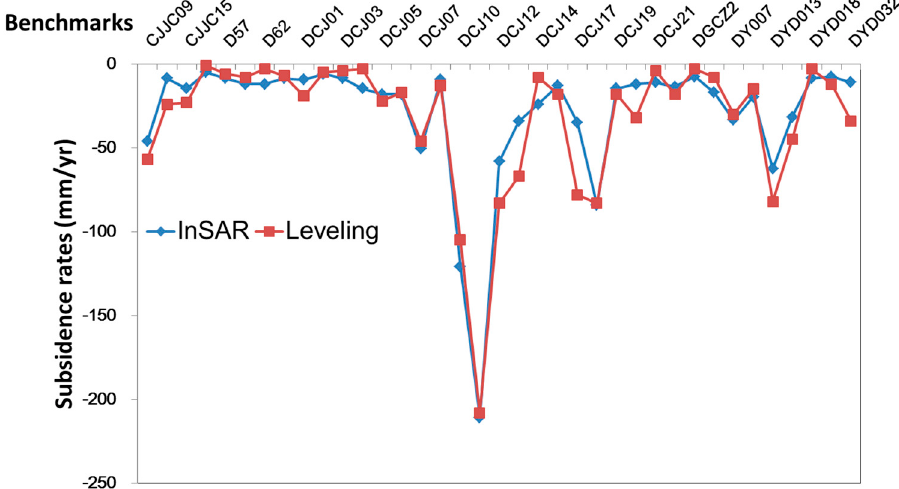
Figure 3. Comparison between InSAR and leveling measurements from 2016 to 2017.